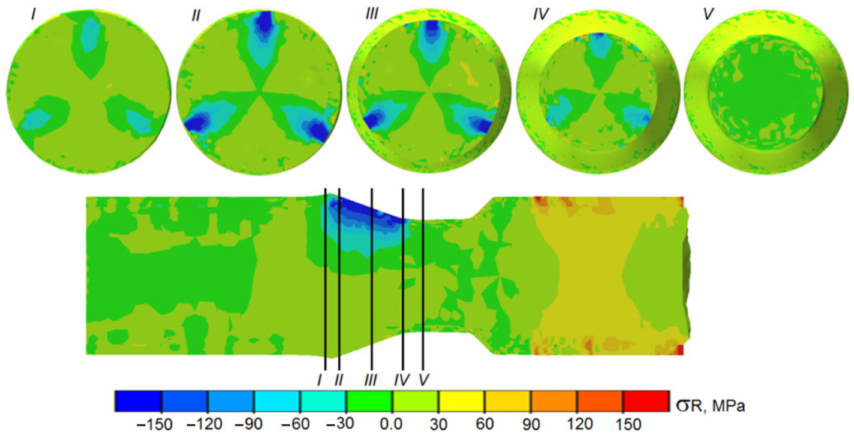
Figure 13. Distribution of radial stress in the tool–workpiece contact zone during the rolling of bimetallic rods modeled by FEM.